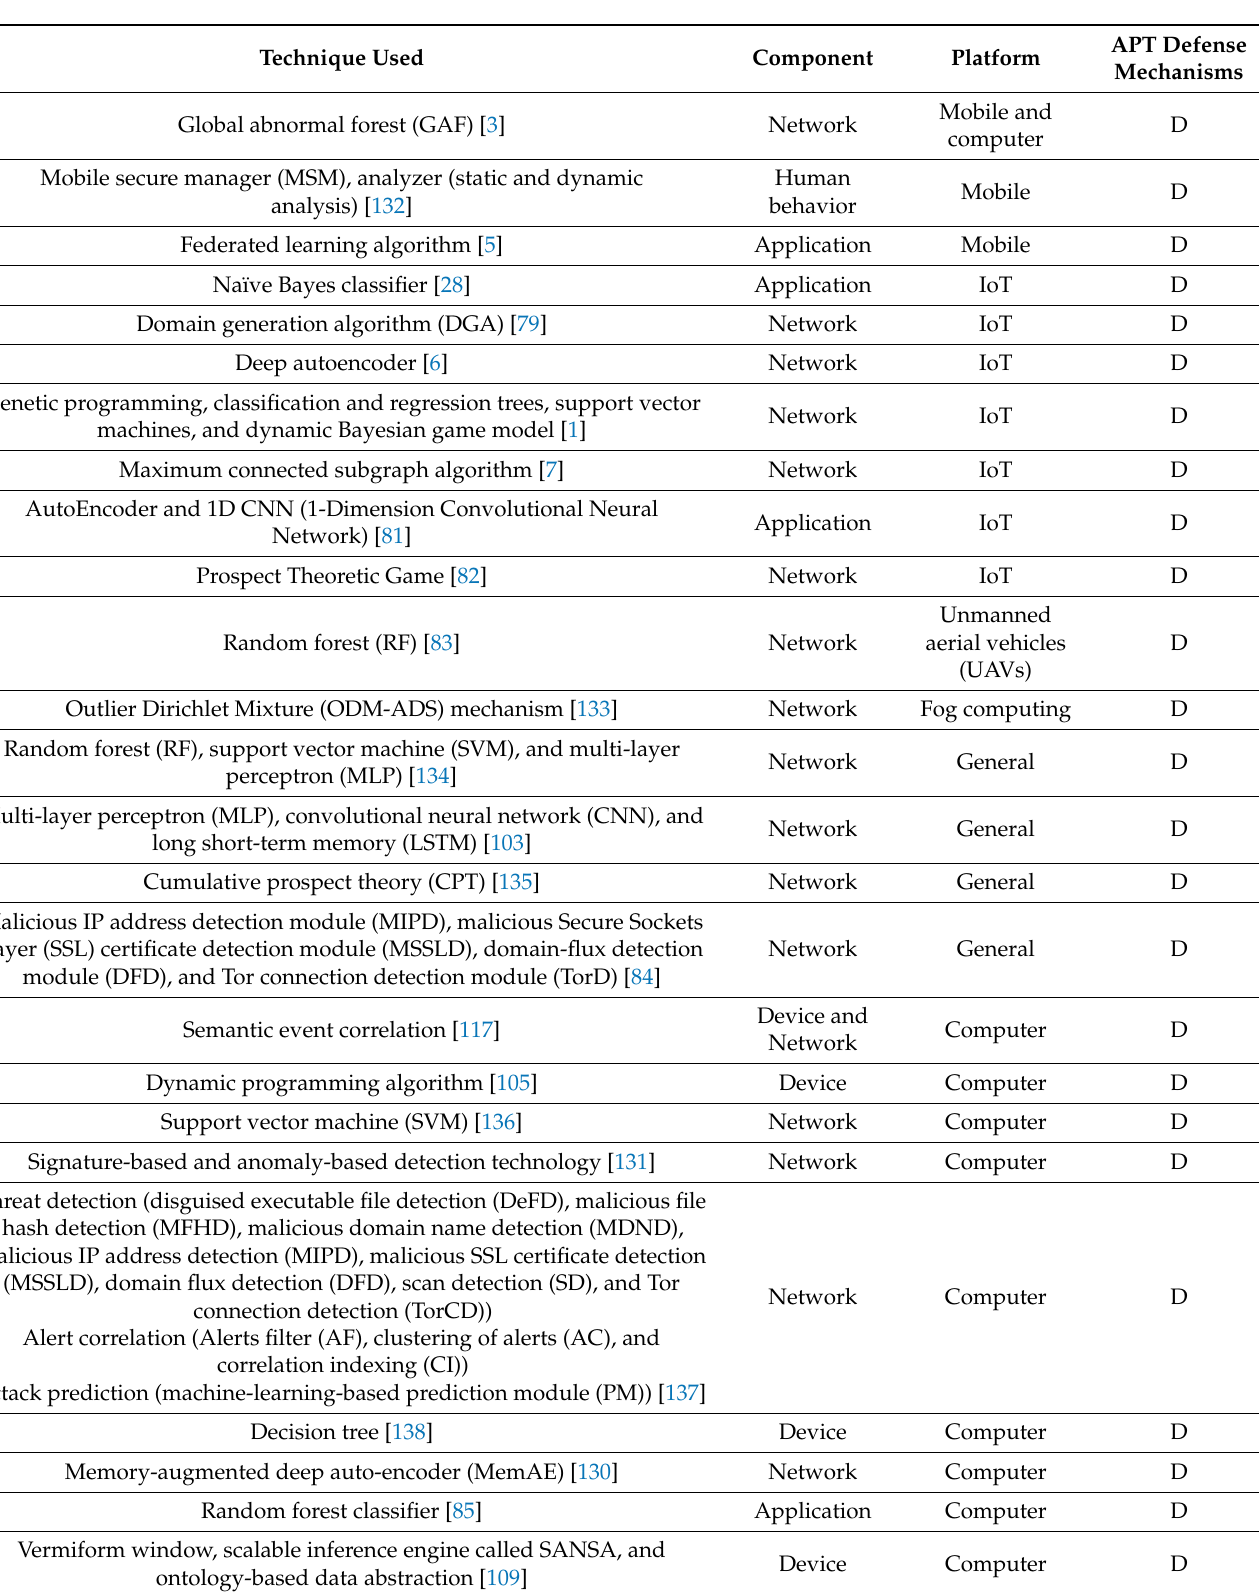
Table 5. APT defense